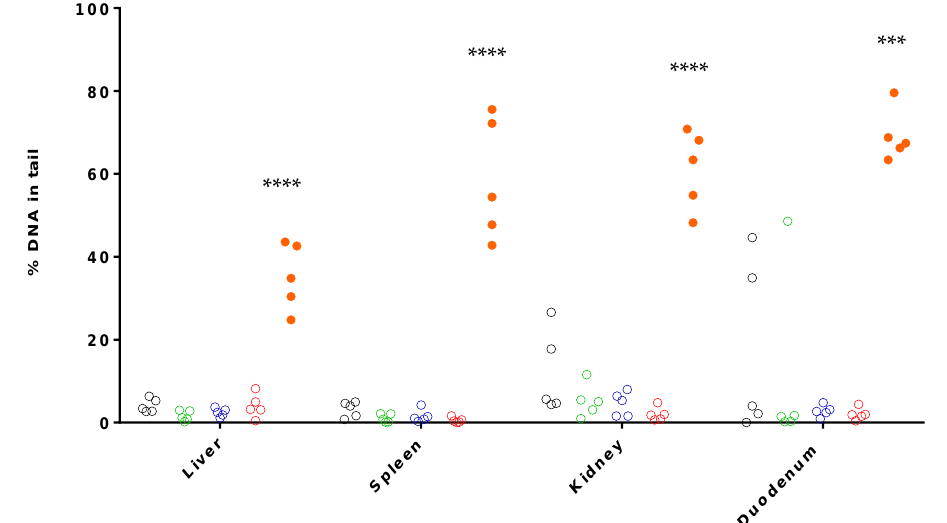
Figure 2. Results of the in vivo standard comet assay in fresh samples of liver, spleen, kidney and duodenum, after 28-day oral administration of the silver-kaolin formulation. The graphic shows the % DNA in tail of each five animals composing negative control (grey), 50 mg/kg b.w. (green), 300 mg/kg b.w. (blue), 2000 mg/kg b.w. (red) and positive control (full orange). *** ( p < 0.005), **** ( p < 0.001).